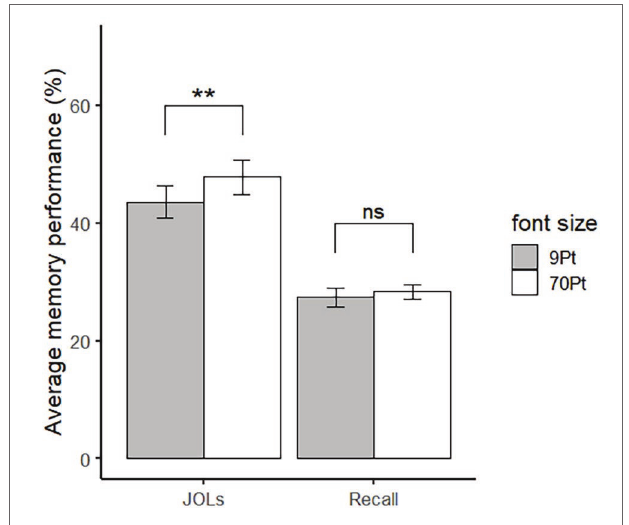
FIGURE 3 | JOLs and recall for large and small words of qualified participants in Experiment 3. Error bar represents ±1 standard error. ∗∗ p <